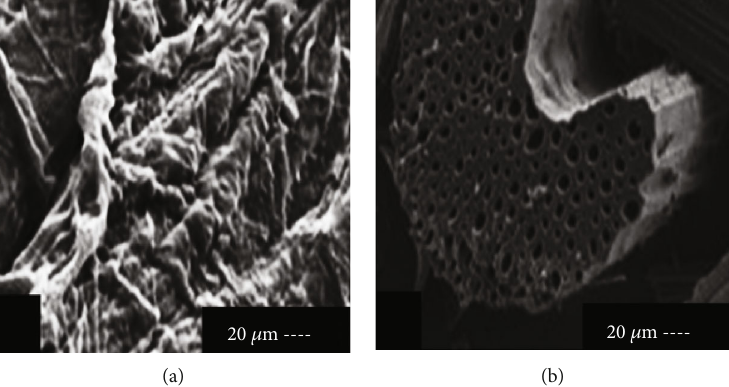
Figure 13: CGF activated carbons (a) longitudinal surface; (b) cross section.